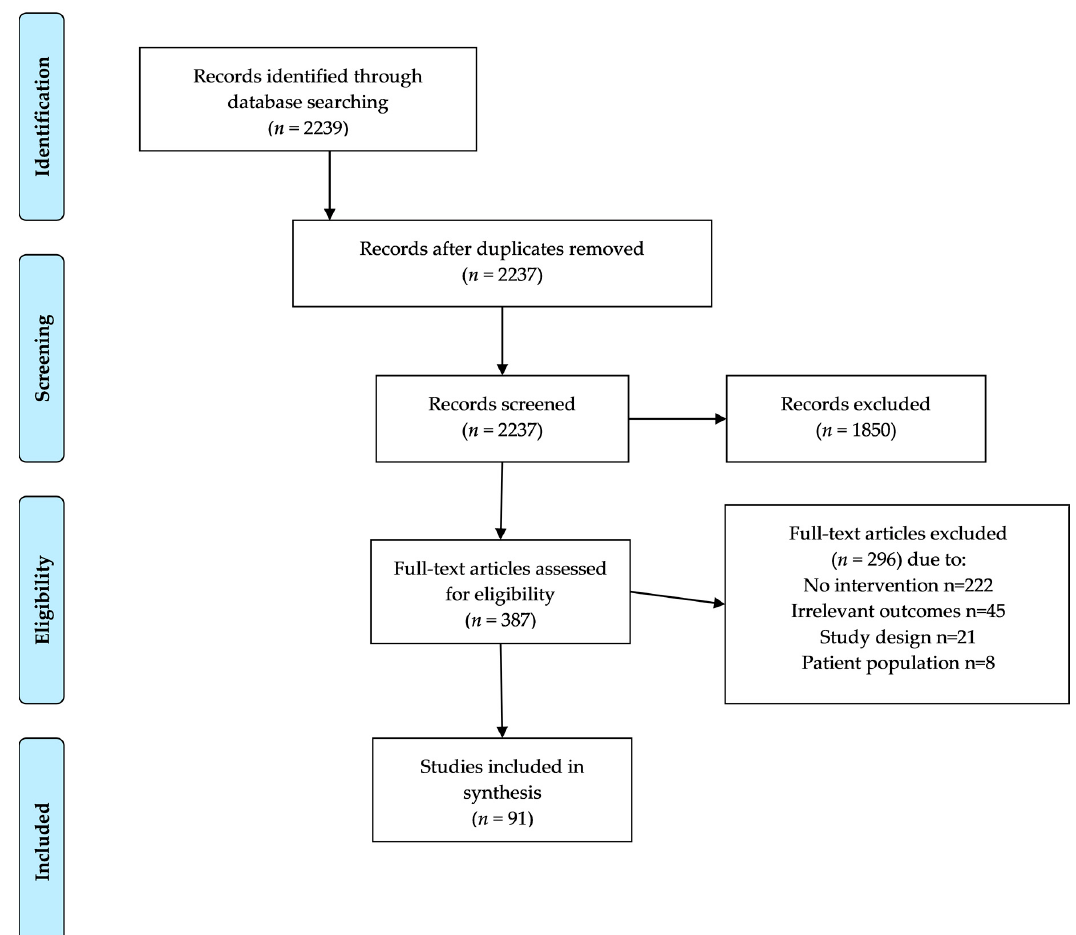
Figure 1. Flow diagram of identified and included